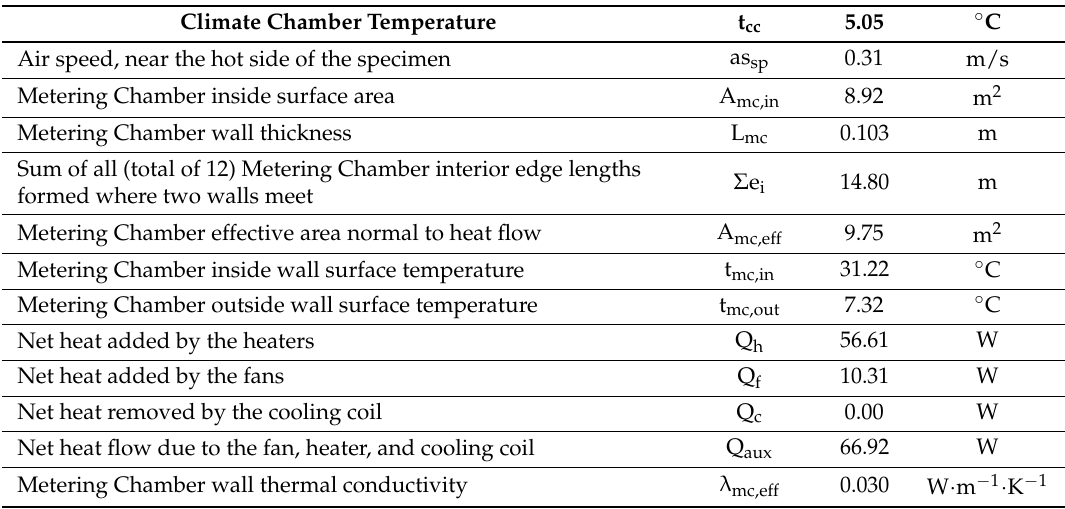
Table 3. Determination of the Thermal Conductivity of the walls of the MC.